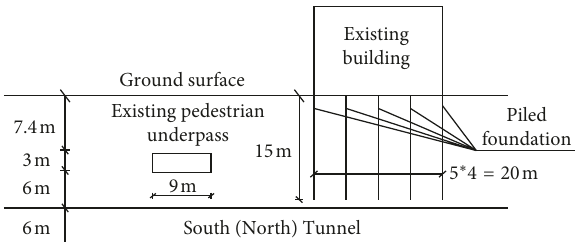
Figure 2: Section view of 1-1.